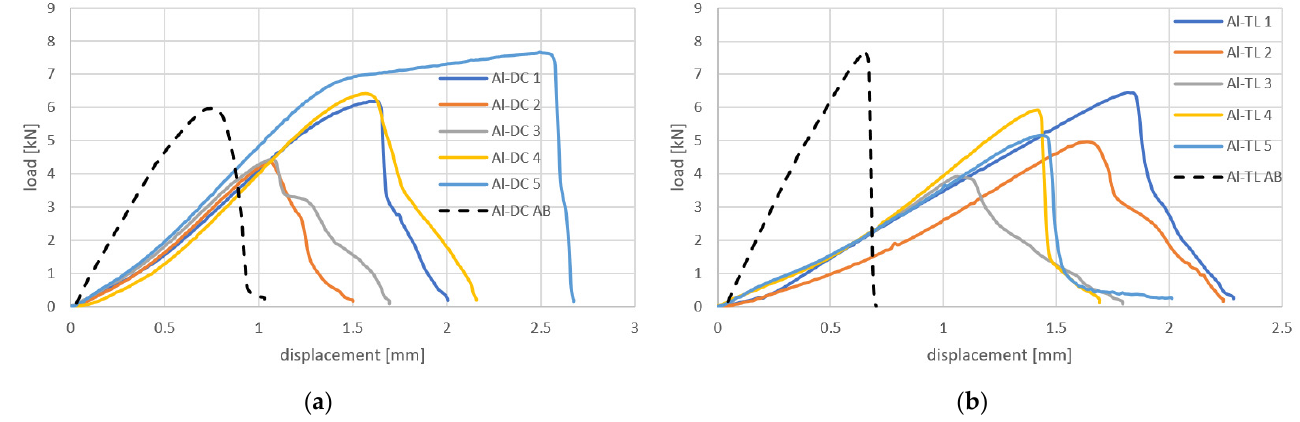
Figure 13. Load–displacement curves for ( a ) Al-DC and ( b ) Al-TL joints made by resistance spot welding + AB, compared with adhesive bonding only (dashed black line).